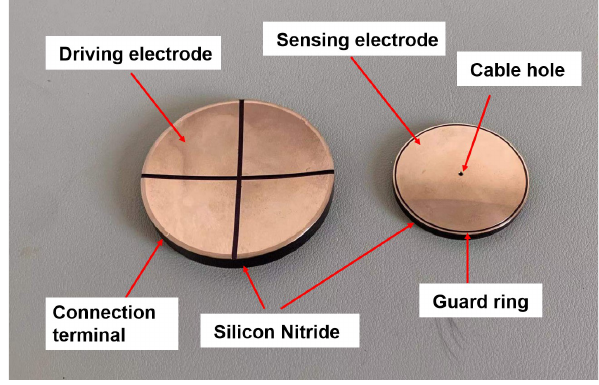
Figure 7. Capacitive sensor electrodes.